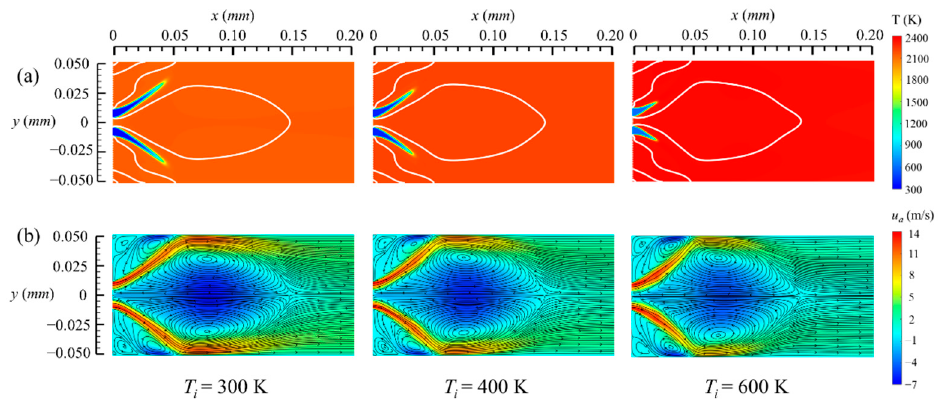
Figure 10. ( a ) Temperature contour along with zero axial velocity isolines, and ( b ) axial velocity contour along with streamlines of different T i , where S N = 0.60 and V a = 180 L/min.